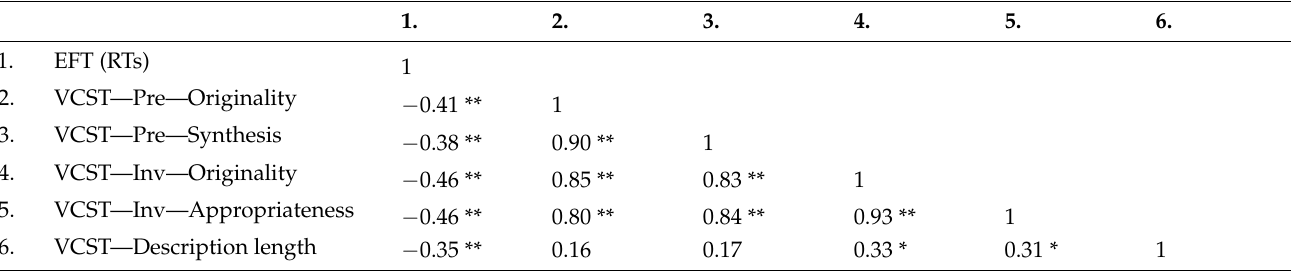
Table 3. Spearman’s Rho partial